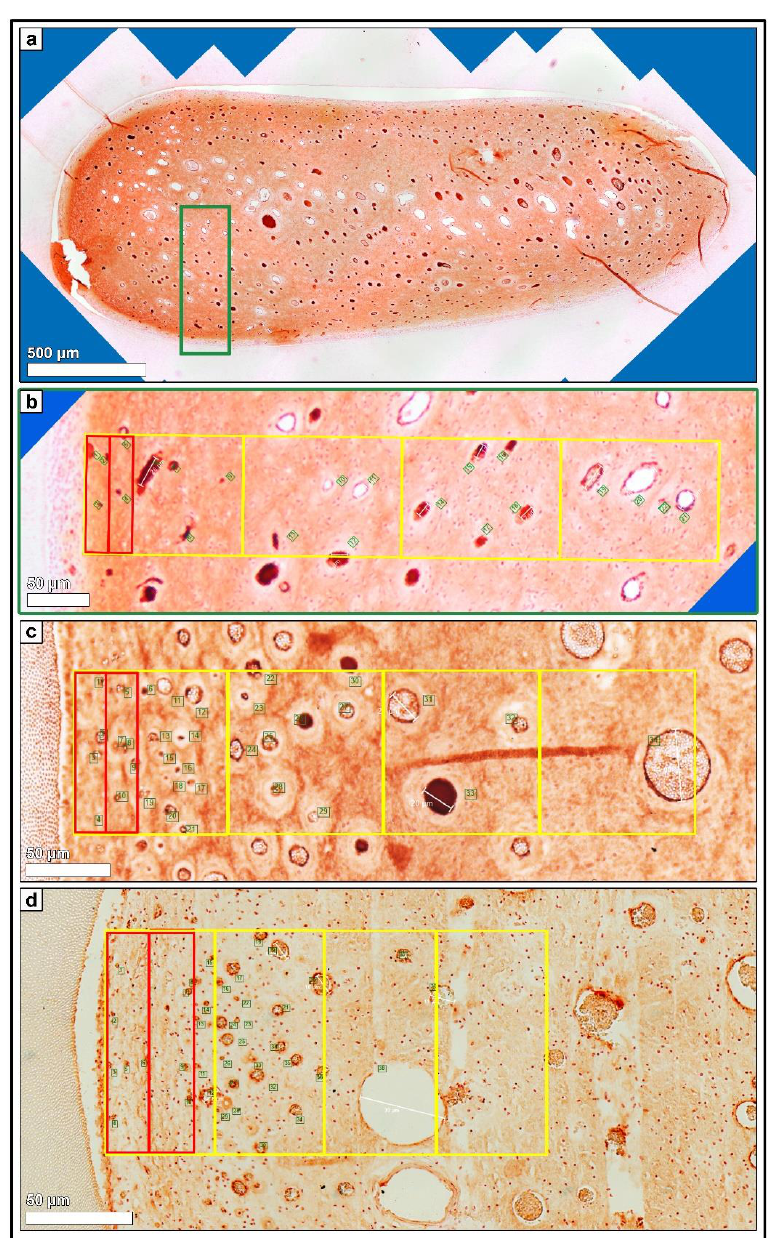
teeth (except for AG 3), showing a significant and step-like decrease from zones 1 to 4, i.e., from peripheral in central direction (incisors: AG 2: zones 1.a and 1.b vs. zones 2, 3 and 4: p ≤ 0.01; zone 1 vs. zones 2, 3 and 4: p ≤ 0.05; cheek teeth: AG 2: zone 1.a vs. zone 1.b: Vet. Sci. 2022 , 9 , 602 p = 0.026; zone 1.a vs. zones 2, 3 and 4: p = 0.002; see Tables S3.2 and S3.3).